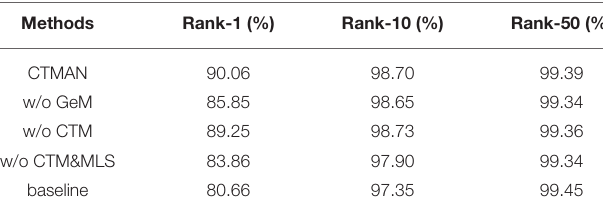
TABLE 4 | Results of the CTMAN, w/o GeM, w/o CTM, w/o CTM&MLS, and baseline on the S3 setup.